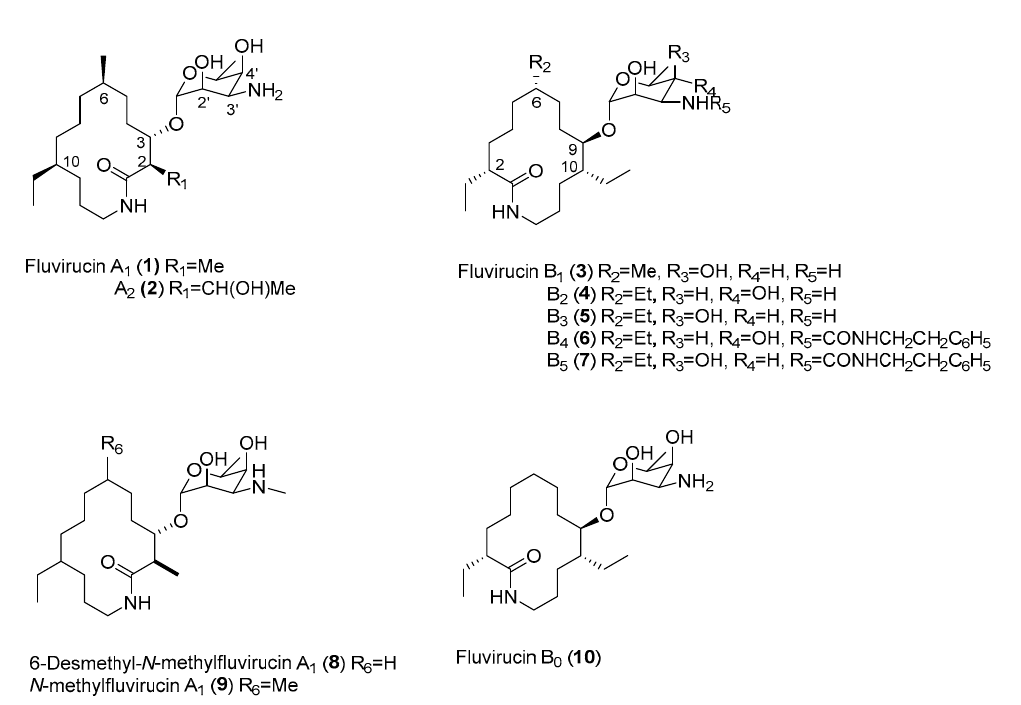
Figure 1. Structures of fluvirucins.